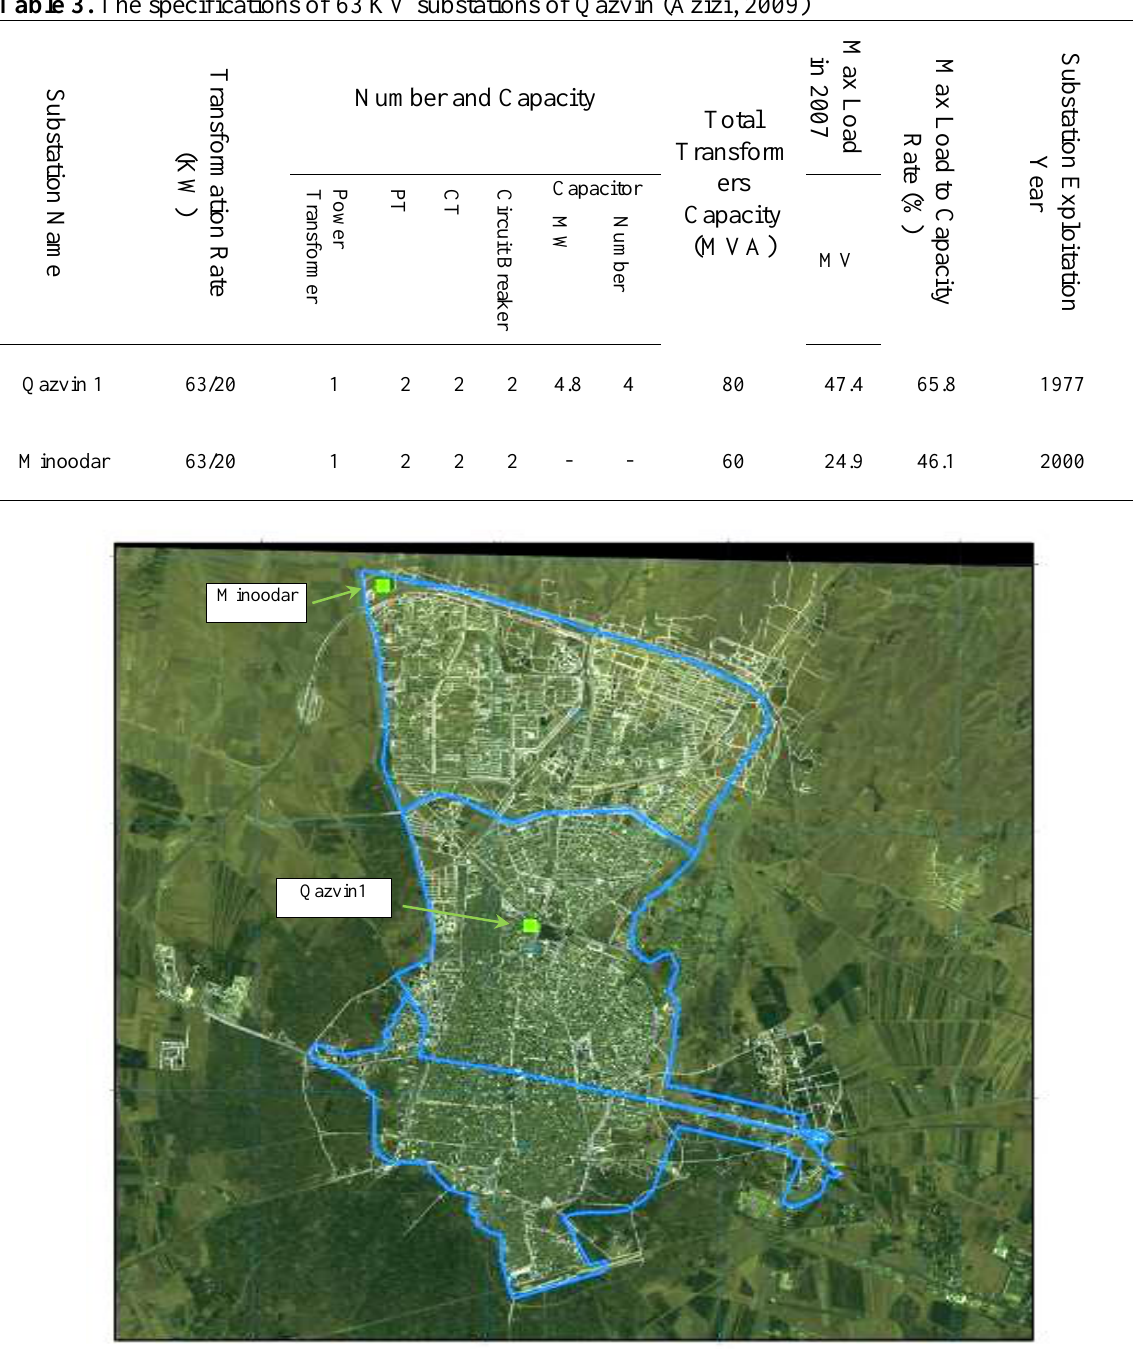
Figure 5. Aerial photo of the city of Qazvin, including the 63KV power substations of this city ( Azizi, 2009